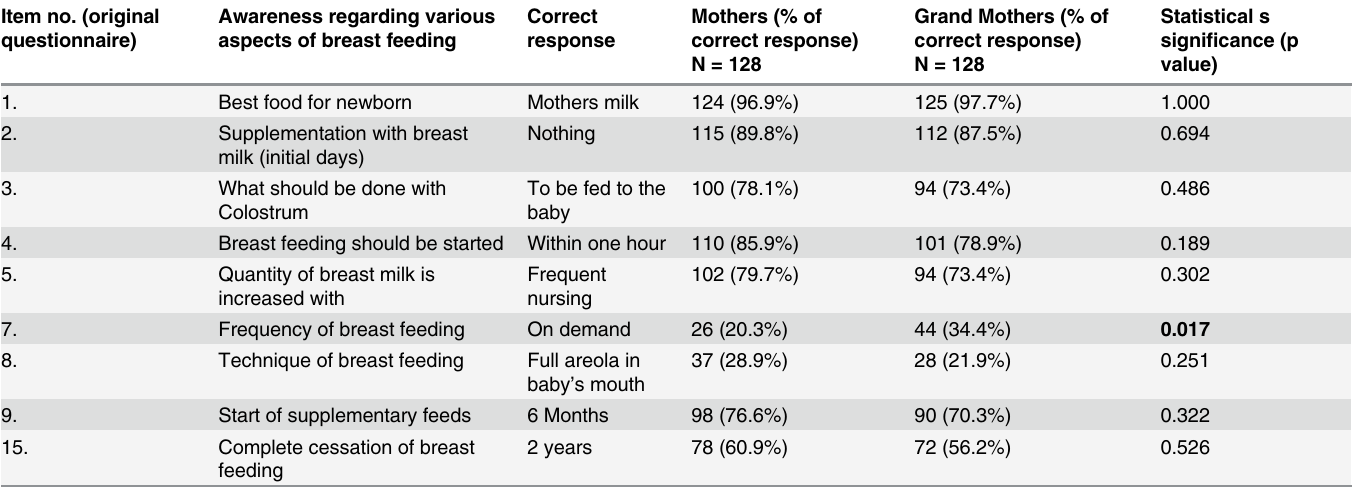
Table 2. Comparison of awareness regarding initiation, cessation, frequency and technique of various aspects related to breast feeding among two generations. Item no. (original